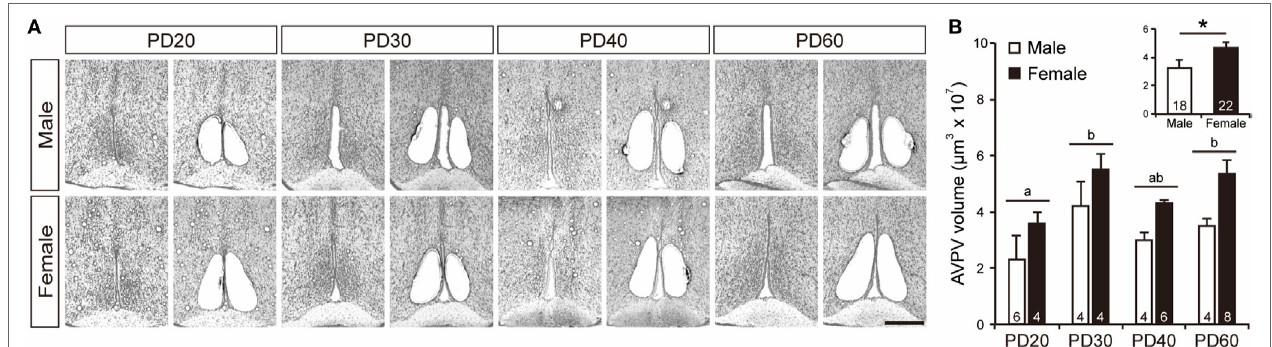
FigUre 1 | Isolation of the AVPV. (a) Representative photographs showing brain sections before and after the AVPV was isolated in male and female mice on PD20–60. Scale bar indicates 400 µm. (B) The volume of AVPV tissues isolated from the brain of male and female mice on PD20, PD30, PD40, and PD60. The inset graph in panel (B) indicates the average volume of the AVPV in all ages. The numbers in the columns indicate the numbers of animals. Values are the mean ± SEM. Differences in values that are significantly ( p < 0.05) different from each other are indicated with letters. * p <